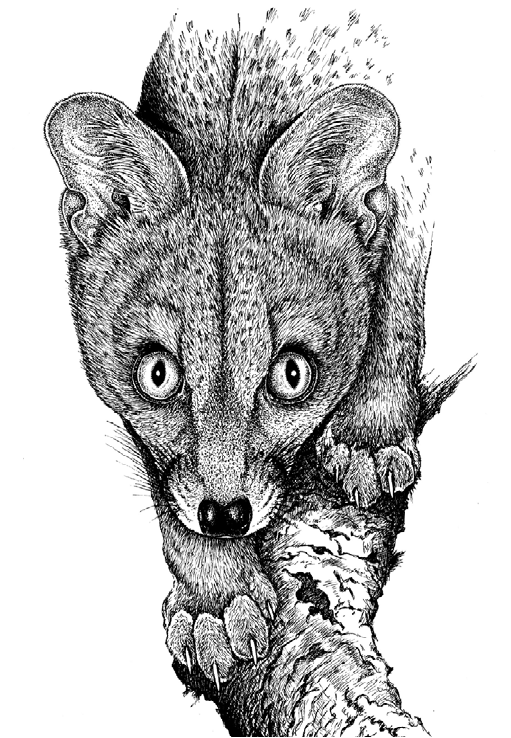
Image 12. Small Indian Civet Viverricula indica . Illustrated using technical pen (Rotring .30) for the book Footsteps through the Salad (Wrey 2012).